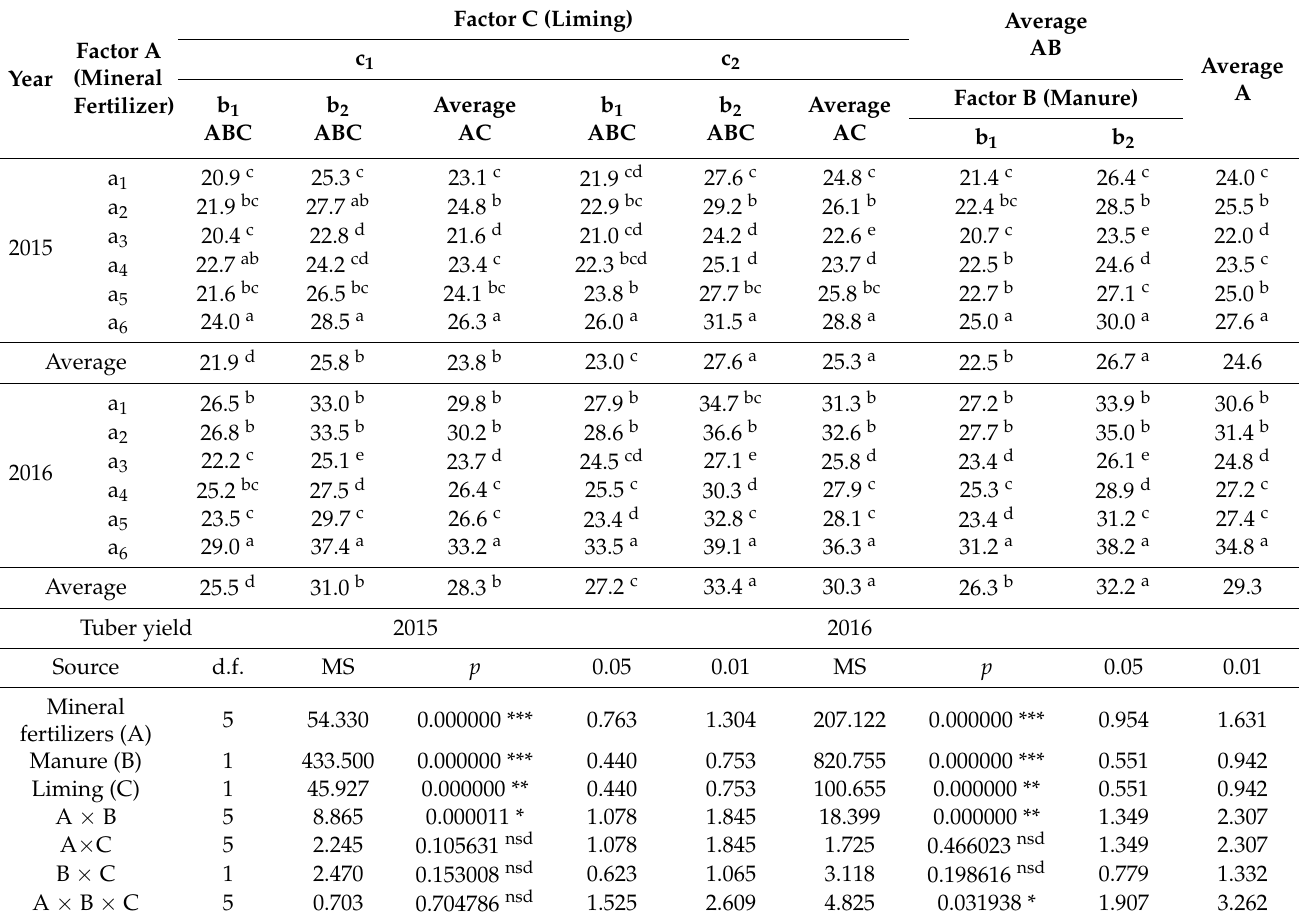
Table 6. The influence of the applied fertilizers on average tuber yield (t ha − 1